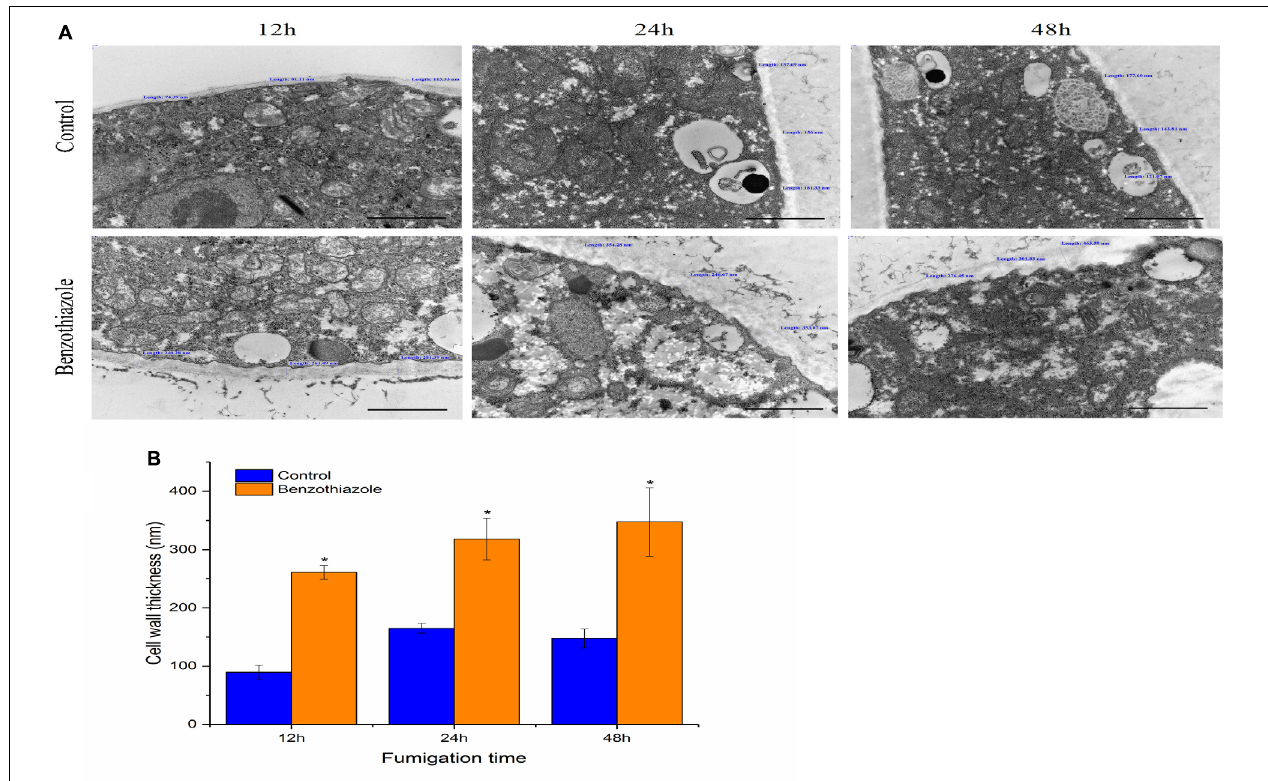
FIGURE 2 | Effects of benzothiazole on the cell wall thickness of Botrytis cinerea (scale bar = 1 µ m). (A) High magnification of the cell wall of B. cinerea showing thickness measured at three different positions of the cell wall. (B) Statistical analysis of the cell wall thickness of benzothiazole-treated and control B. cinerea . The asterisk indicates a significant difference from the respective